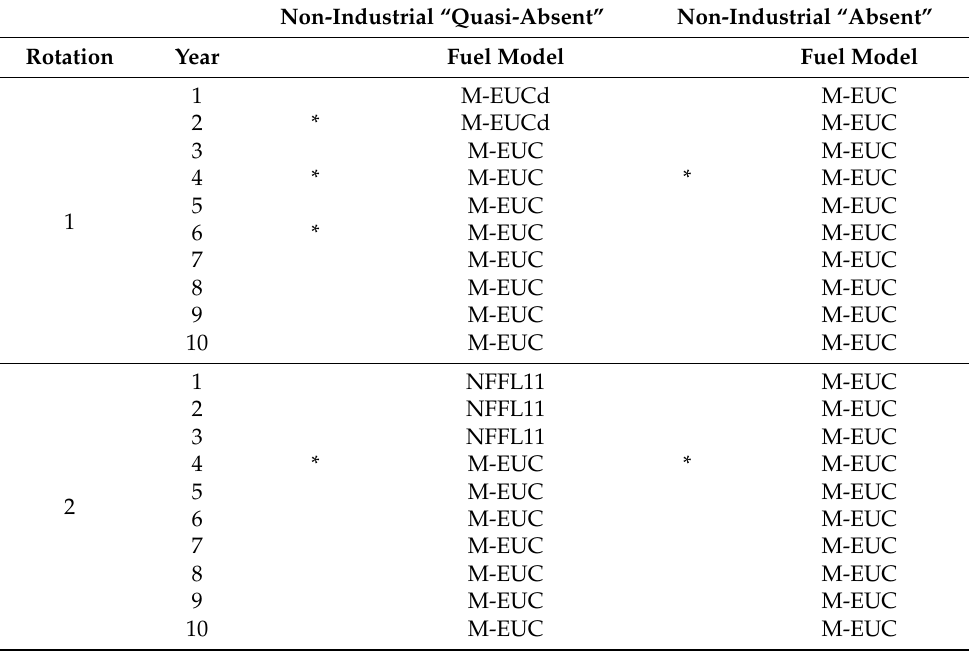
Table A2. Fuel model distribution across time for three eucalypt rotations: industrial FMA and non-industrial “quasi-absent” and “absent” FMA. Acronyms are explained in Table 1 of the main